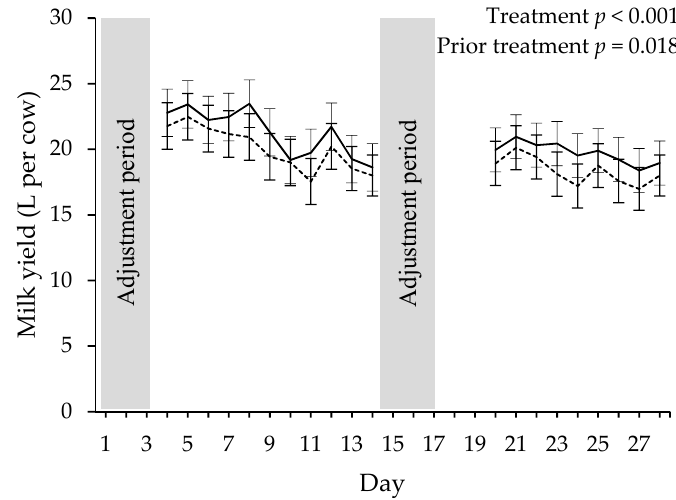
Figure 1. Changes in milk yield (litres per cow) for cows fed daily pasture allocation in 2 feeds per day (solid line) or 7 feeds per day (dotted line) over 11 days prior to (days 4–14) and 9 days following (days 20–28) an incomplete treatment cross-over at day 15. No data were collected in the adjustment periods (days 1–3 and 15–17). Due to a technical malfunction, no milk yield data were recorded at days 18 and 19. Least square means ± 95% confidence interval, calculated using linear mixed models, are presented.